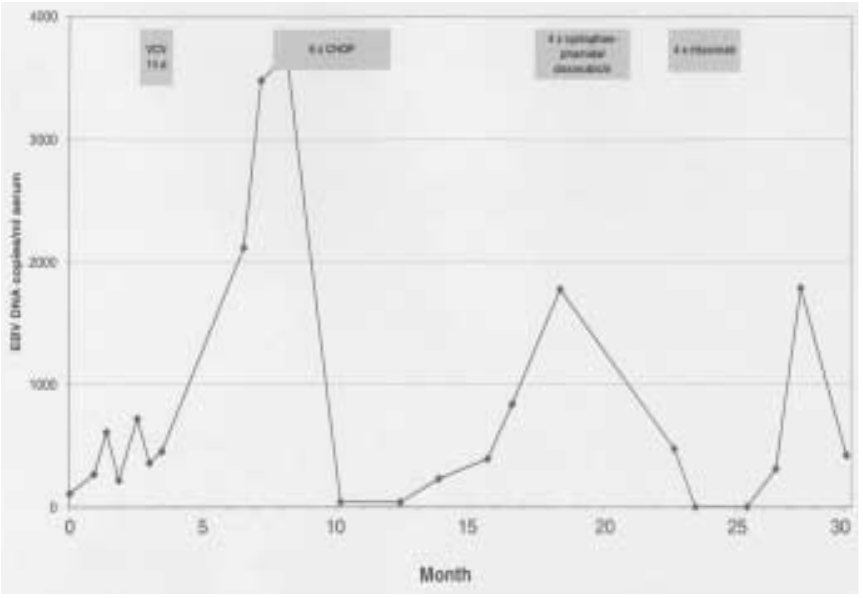
Figure 1 Serum levels of EBV DNA measured with a real-time poly- merase chain reac- tion assay in a HIV- positive haemophilic patient. A continuous rise was observed despite an intermit- tent valacyclovir (VCV) treatment. Nine months later an EBV-associated large B-cell lymphoma was diagnosed, followed by chemotherapy (CHOP), with a com- plete